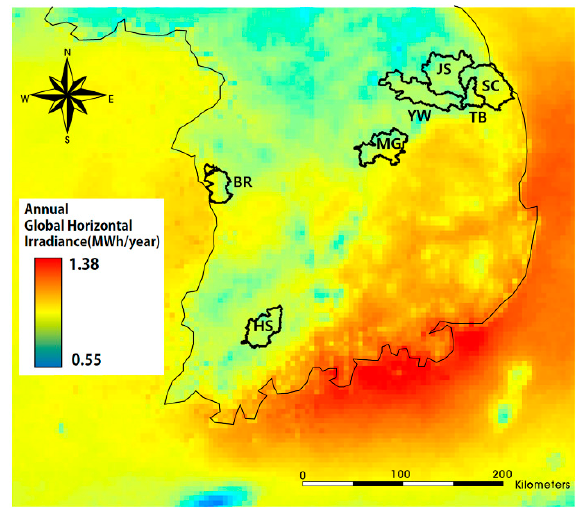
Figure 1. Locations of seven abandoned mine promotion districts in Korea (modified from Song et al.